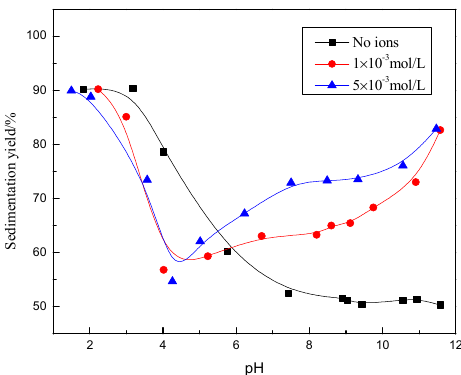
Minerals 2016 , 6 , 93